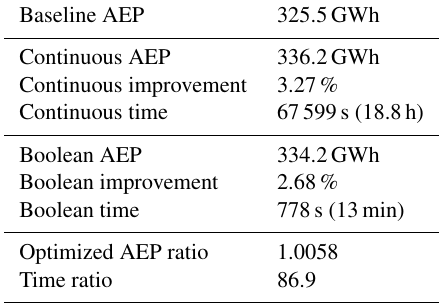
Table 1. The results comparing the yaw optimization with the con- tinuous approach to our Boolean approach. The last two lines show the optimized AEP ratio and the time ratio, which is the continuous approach result divided by the Boolean approach